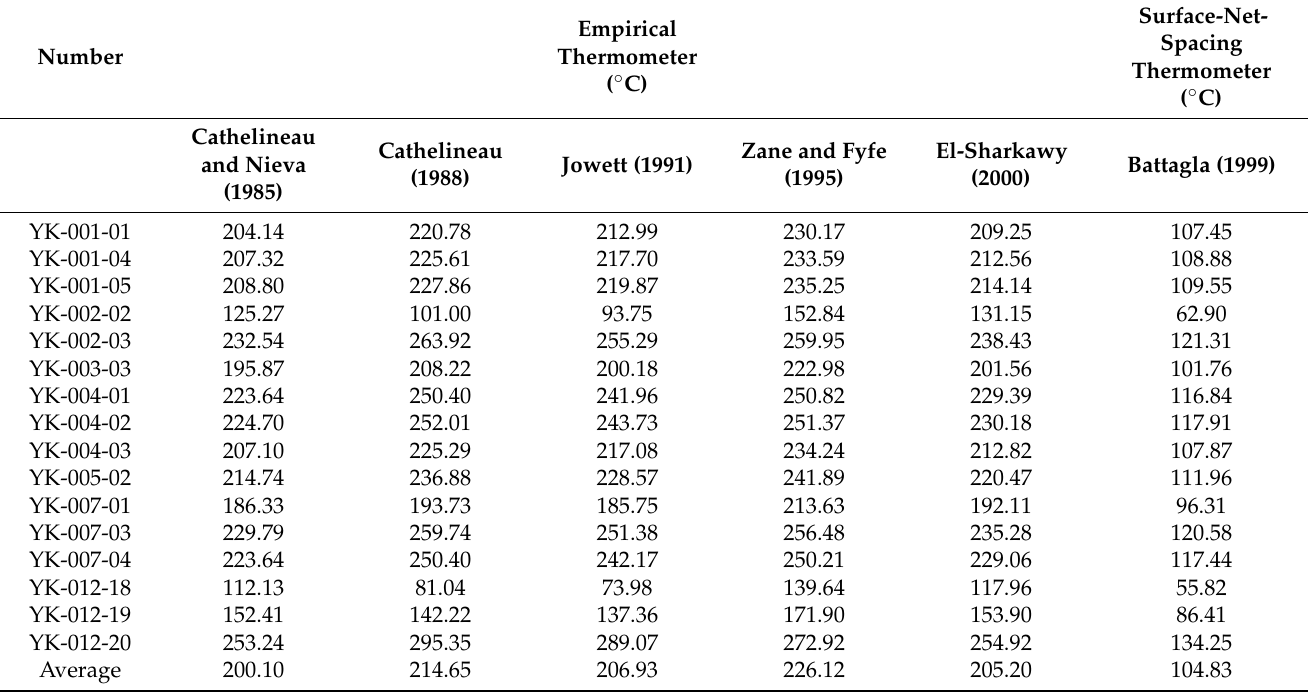
Table 9. Calculation results of chlorite temperatures in “Laoshan Jade”.